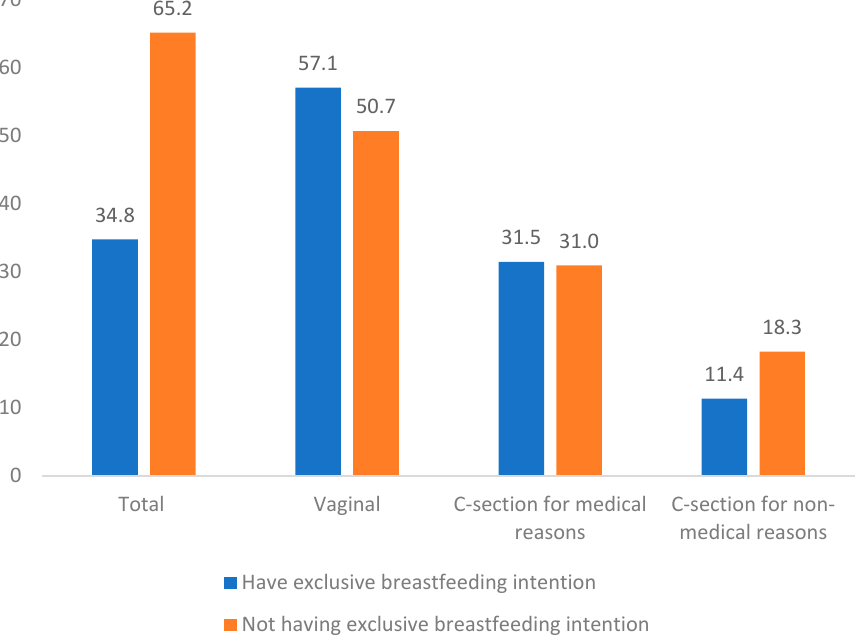
Figure 1. The exclusive breastfeeding intention and modes of delivery in Hanoi 2021 ( N = 529).